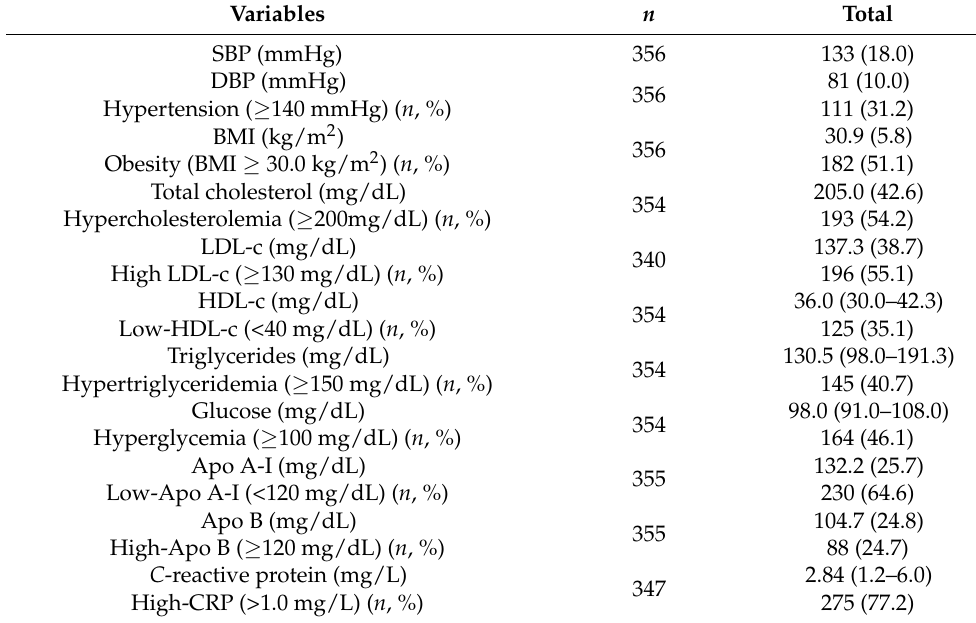
Table 2. Biochemical and clinical characterization of